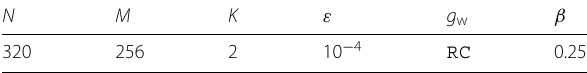
Table 2 Parameter settings for one specific example